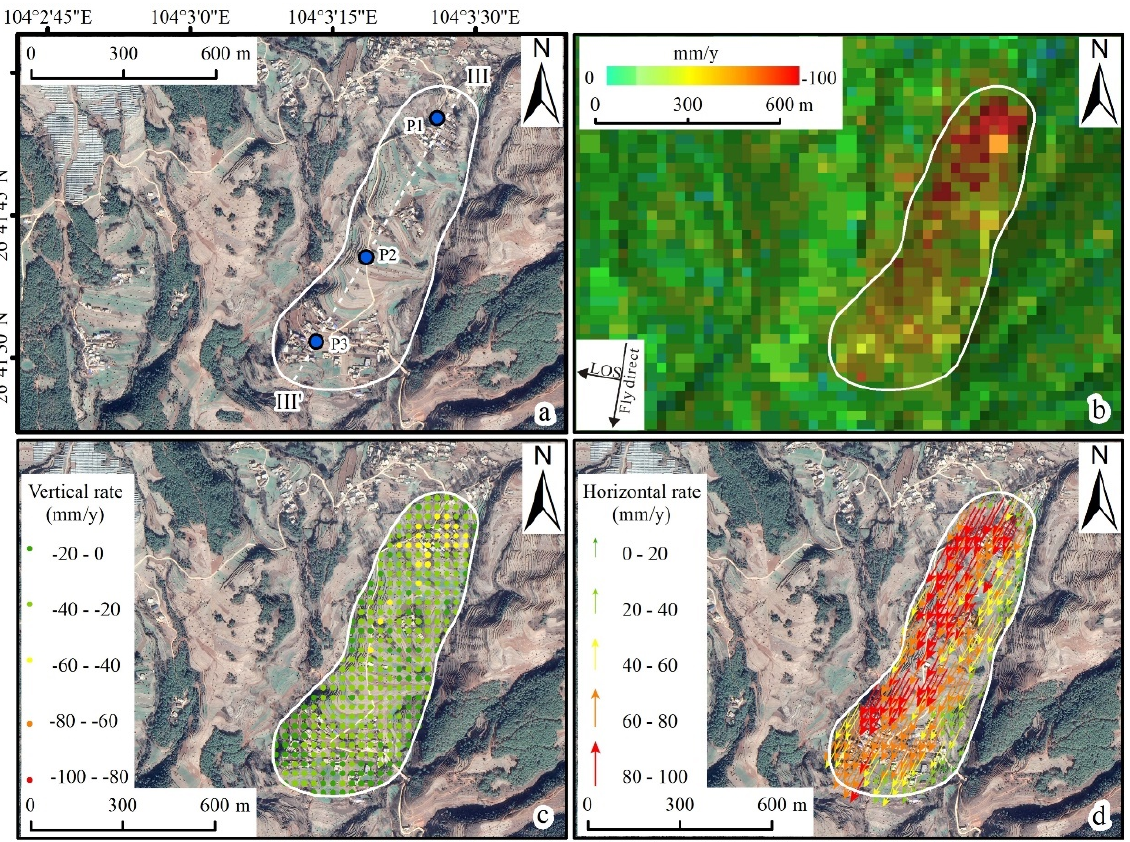
Figure 12. ( a ) Overview of LYY landslide; ( b ) annual average displacement in LOS direction obtained from Sentinel-1 descending images; ( c ) vertical rate; ( d ) horizontal rate.